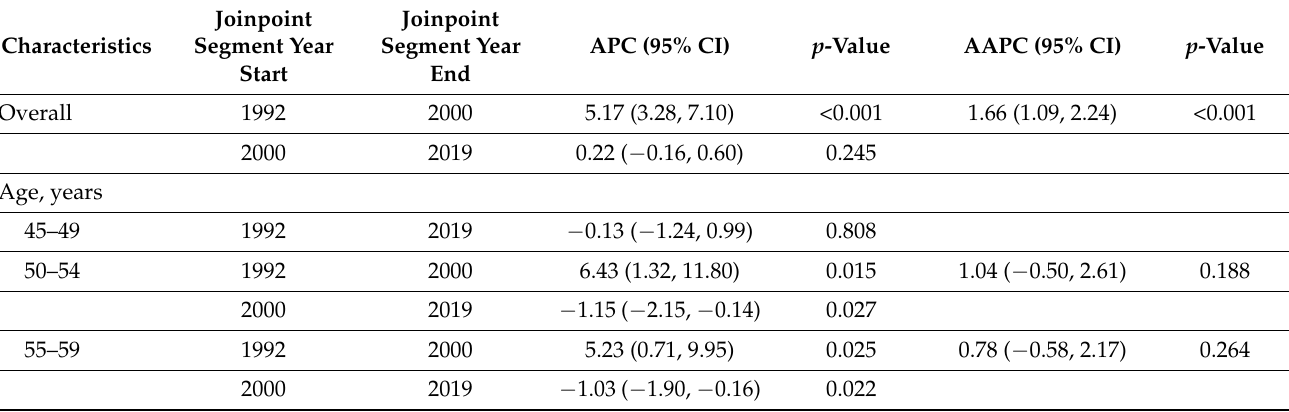
Table 2. Annual percent change (APC) and average annual percent change (AAPC) in EAC rates over time, overall, and by age group, sex, and